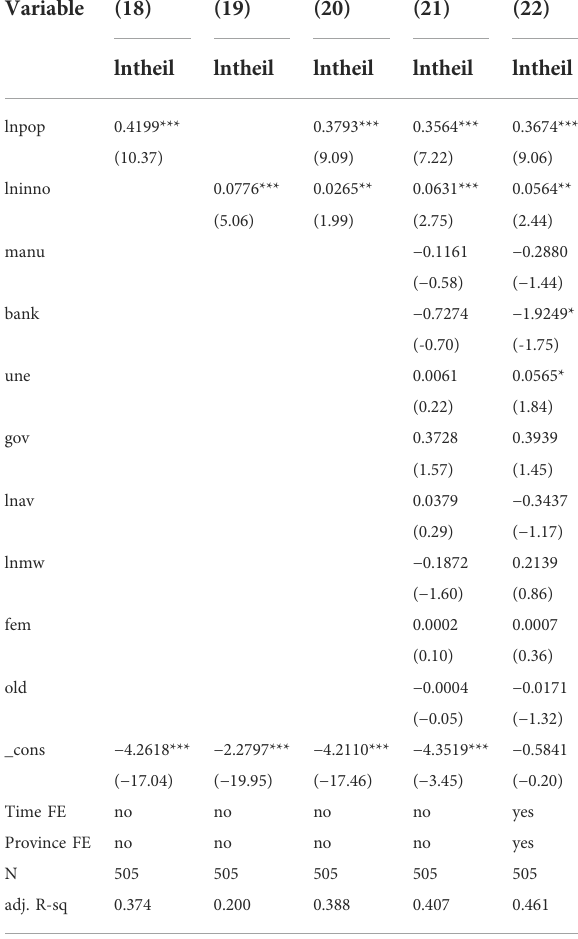
TABLE 8 Robustness tests: alternative proxy measure of income inequality. Variable